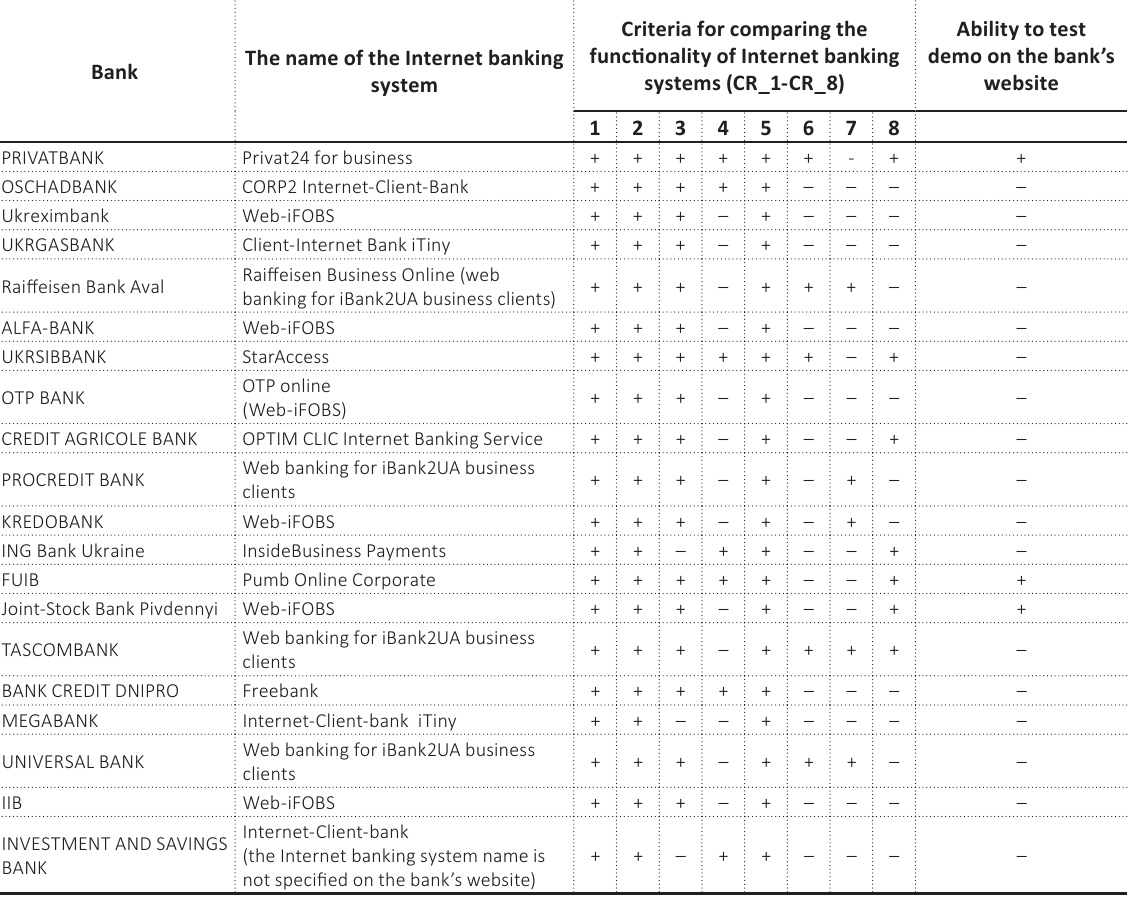
Table 8. Results of comparison of Ukrainian banks on the functionality of Internet banking systems for servicing enterprises Source: Summarized by the authors based on information provided on the banks’ official